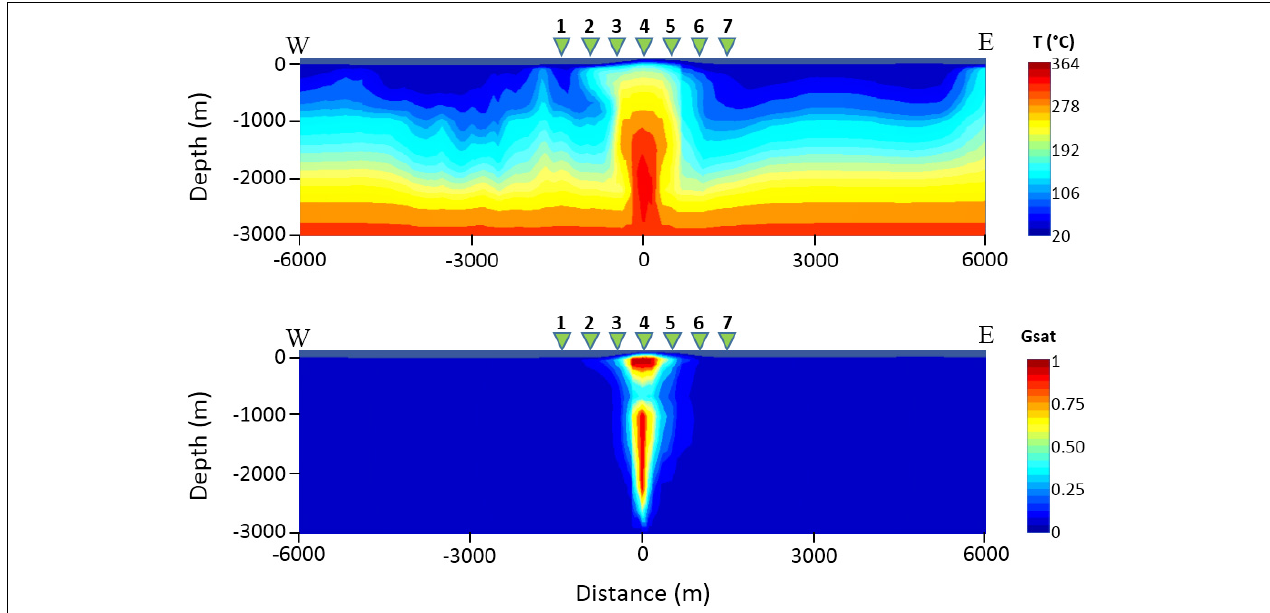
FIGURE 4 | Temperature (upper panel) and gas saturation (lower panel) distributions retrieved from the Campi Flegrei model proposed by Petrillo et al. (2013) along the red line shown in Figure 3 . The green triangles 1–7 indicate the MT